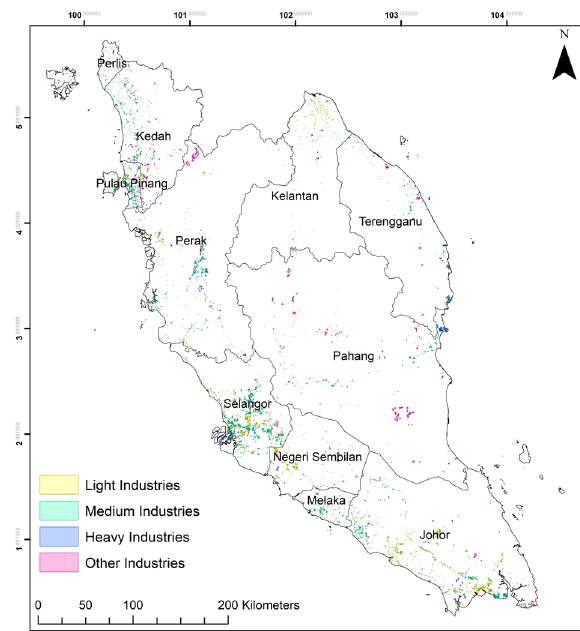
Figure 1 . Industrial areas in Peninsular